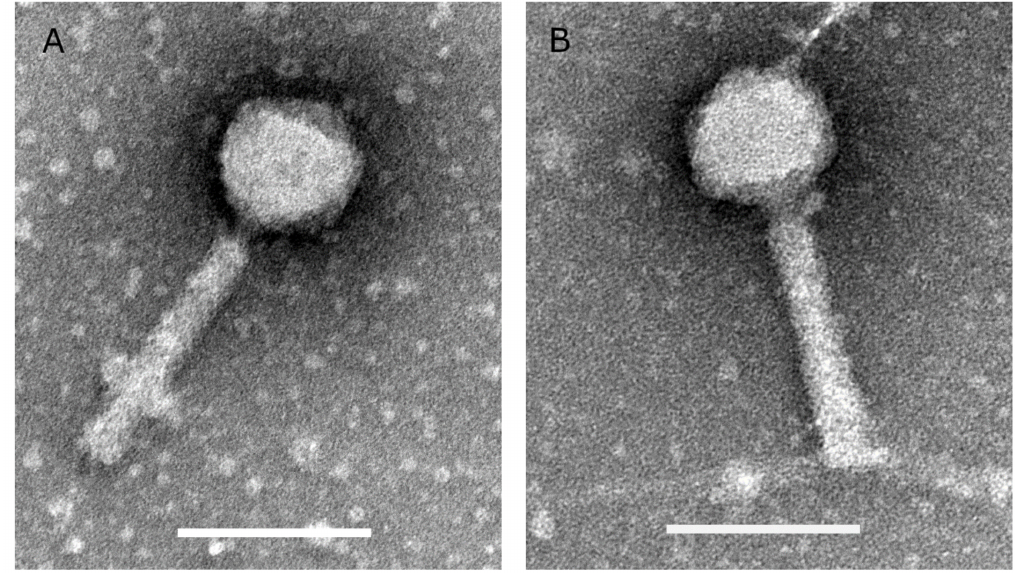
Figure 1. Transmission electron microscopic images of phages ( A ) V523 and ( B ) V524. The scale bars are 100